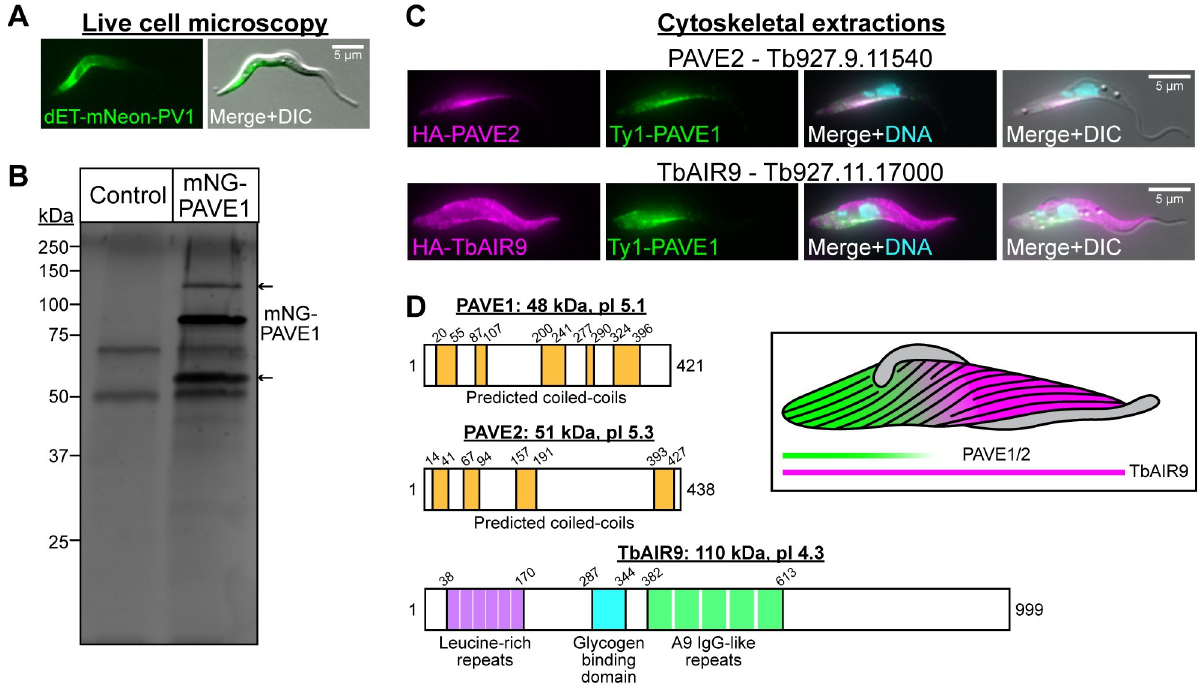
Fig 4. Immunoprecipitation of mNeonGreen-PAVE1 reveals two interacting partners. (A) Representative image of a live T . brucei cells expressing mNeonGreen-PAVE1 from both endogenous loci. (B) dET-mNeonGreen-PAVE1 cells were harvested, lysed, and sonicated to solubilize cytoskeletal proteins. Clarified supernatant was batch-bound with magnetic camelid nanobodies against mNeonGreen. Beads were washed 6X and bound proteins were analyzed by mass spectrometry. Gel is a representative silver-stained SDS-PAGE gel of the elution from the mNeonGreen immunoprecipitation in control and mNeonGreen-PAVE1 samples. Both lanes are 50% of input material. Arrows indicate the two major unique protein bands present in the mNeonGreen-PAVE1 sample not present in WT 427 controls. (C) The two potential interacting partners of PAVE1 identified in the mNeonGreen-PAVE1 immunoprecipitation were endogenously tagged with the HA epitope tag. The cytoskeleton was extracted and cells were processed for immunofluorescence to co-localize each protein with Ty1-PAVE1 using anti-Ty1 and anti-HA antibody. (D) Protein domain schematics including the predicted molecular weight (kDa) and pI for PAVE1, PAVE2, and TbAIR9. PAVE1 and PAVE2 have no recognizable domain homology to any known protein. However, they contain a series of predicted coiled coils [58]. TbAIR9 lacks the basic serine-rich microtubule binding site found in Arabidopsis thaliana AIR9, but does contain the conserved leucine-rich repeats, glycogen binding domain, and A9 IgG-like folds. Inset illustrates the localization pattern of PAVE1, PAVE2, and TbAIR9 across the array.